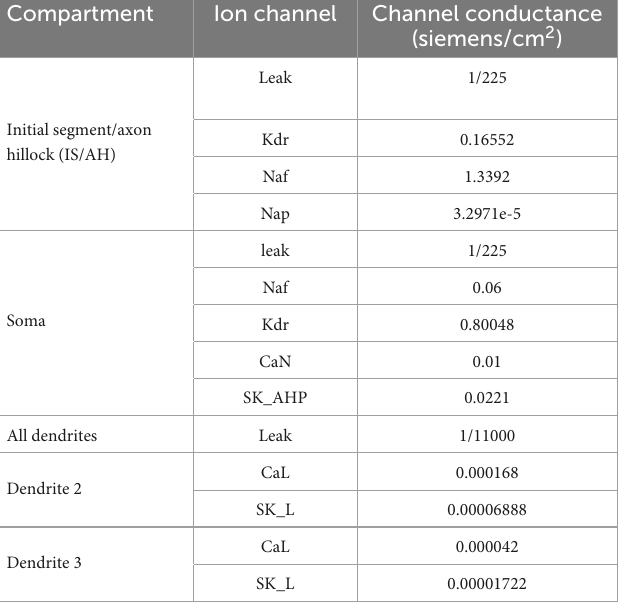
TABLE 2 Channels conductances of the (6C) reduced control model.